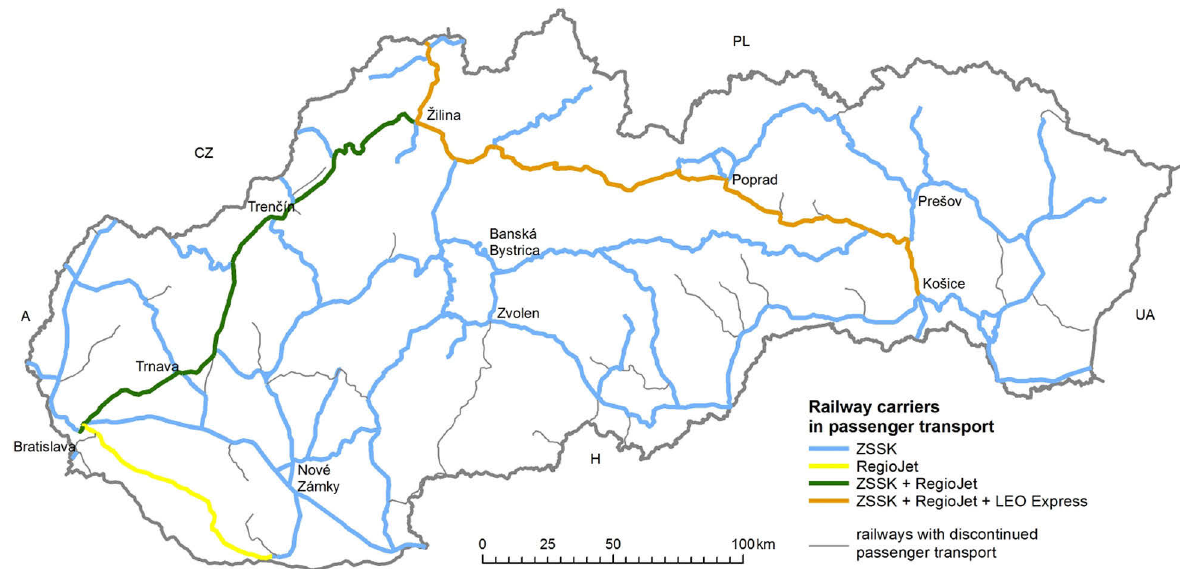
Fig. 7. Railway carriers in passenger transport in Slovakia in